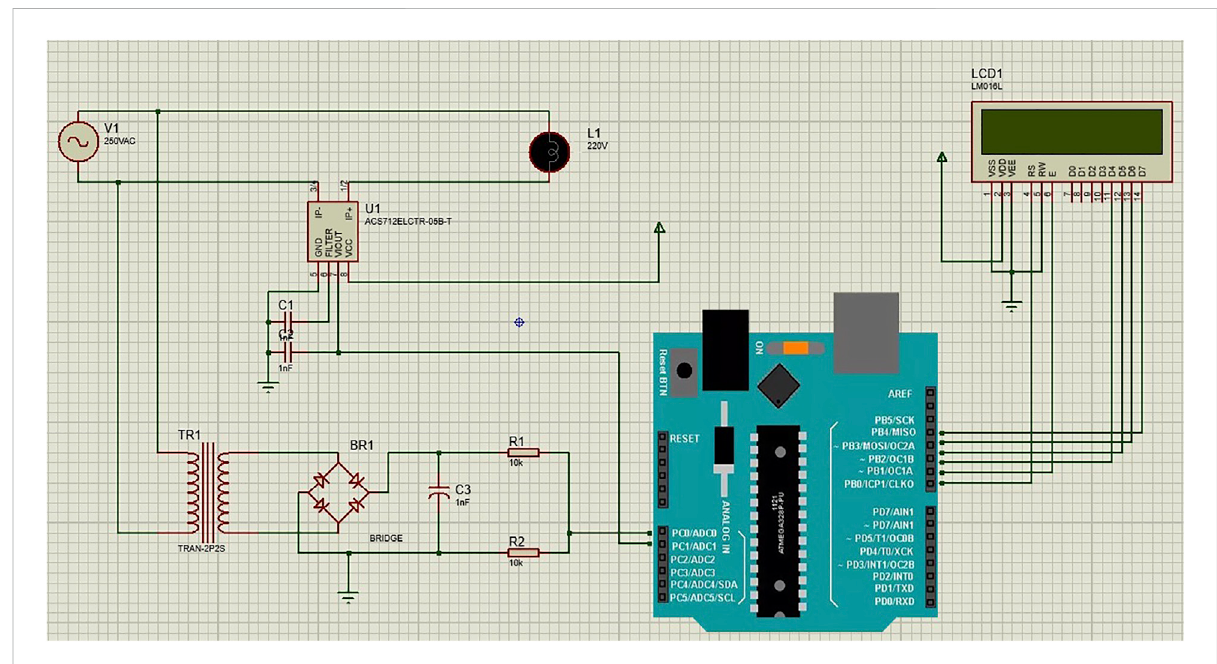
FIGURE 6 Circuit diagram of smart energy meter.